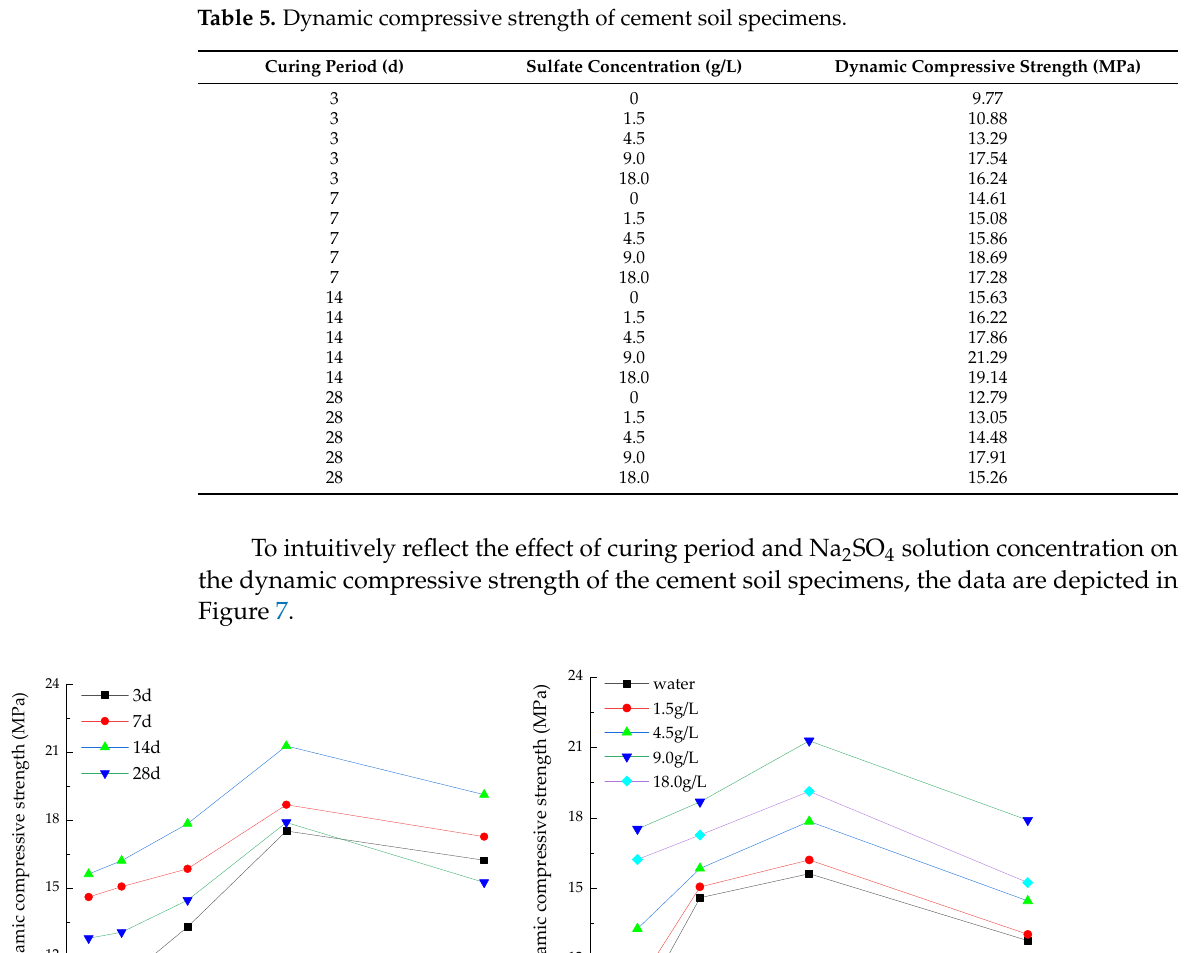
Table 5. Dynamic compressive strength of cement soil specimens.